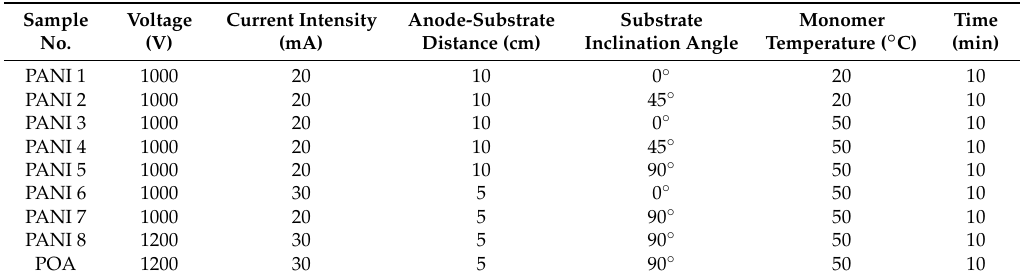
Figure 1. Experimental setup of the employed DC plasma reactor [6,7]. Table 1. Experimental deposition conditions for the polymeric films.